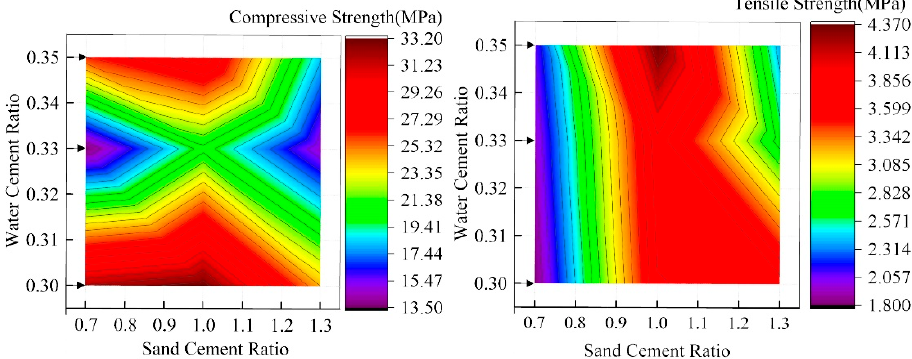
Figure 12. The influence of SCR on compressive strength and tensile strength. Table 4. Correlation coefficients between different porosity and mechanical